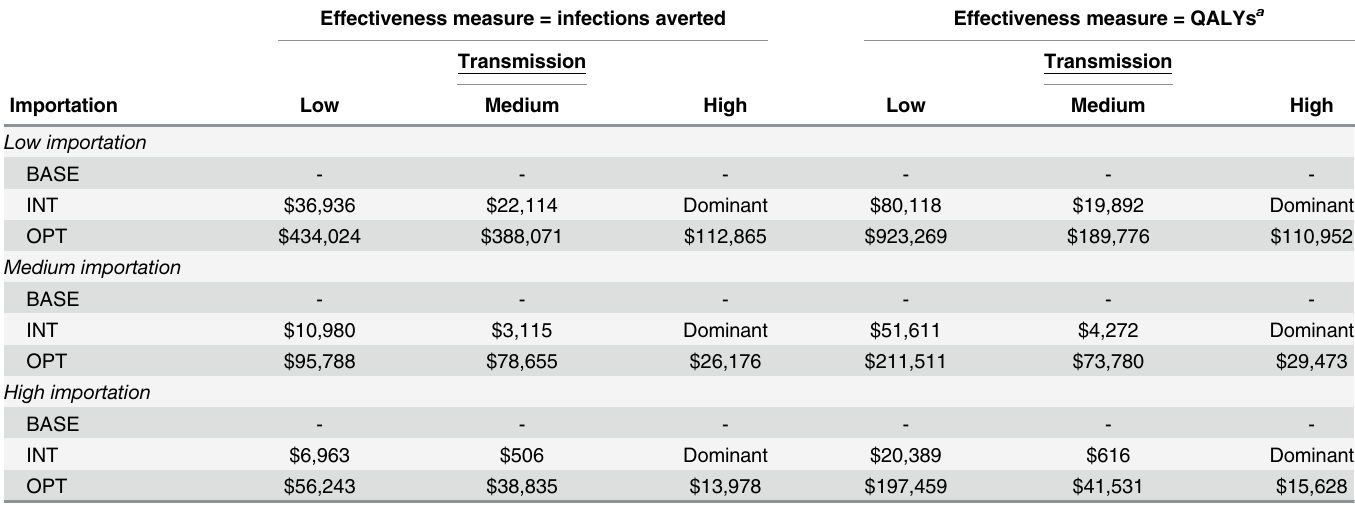
Table 4. Results from cost-effectiveness analysis.